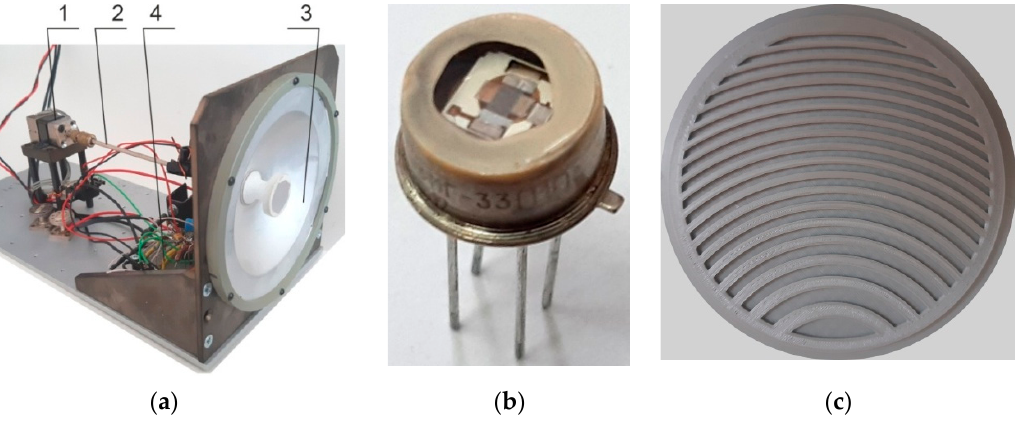
Figure 2. ( a ) Appearance of MM radiation source, consisting of (1) MM emitter, (2) waveguide, (3) Cassegrain antenna, and (4) control board. ( b ) Pyroelectrical photodetector for the MM waveband. ( c ) Image of a Wood zone plate.